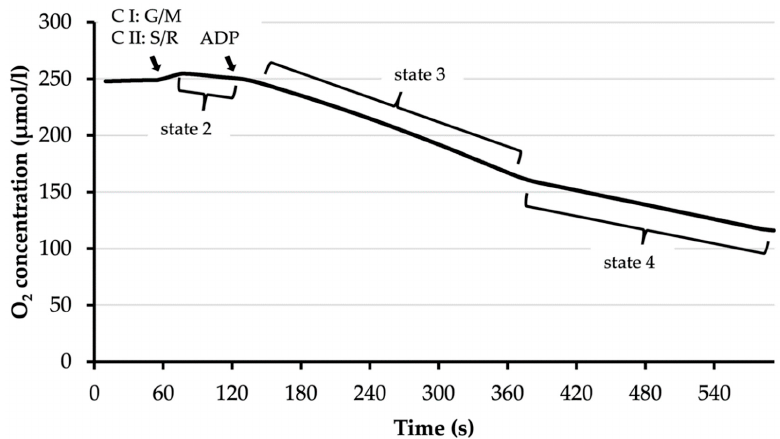
Figure A2. Mitochondrial oxygen (O 2 ) consumption can be divided into different states. State 2 occurs when substrates of the respiratory chain are present except for adenosine diphosphate (ADP). The substrates to fuel into complex I (C I) are glutamate/malate (G/M), while complex II (C II) is propelled by succinate (S) and isolated through blocking complex I with rotenone (R). State 3 is then achieved by adding ADP, which enables the adenosine triphosphate (ATP) synthase. When ADP is completely consumed, O 2 consumption switches into state 4. Respiratory control index (RCI) = state 3/state